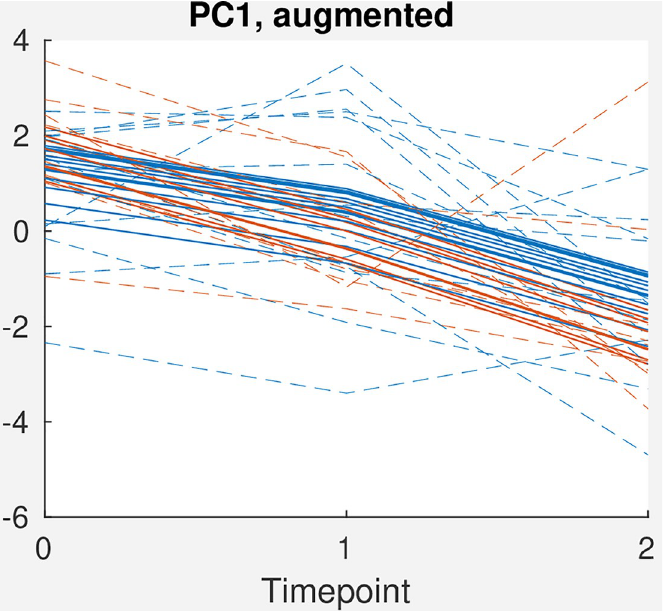
Fig 2. Score plot for PC1 for the effect matrix for time + time � treatment, augmented with random effects (continuous lines) and both random effects and residuals (dashed lines). Only a random subset of patients with complete data are included in the plot. Orange: Chemotherapy + Bevacizumab. Blue: Chemotherapy